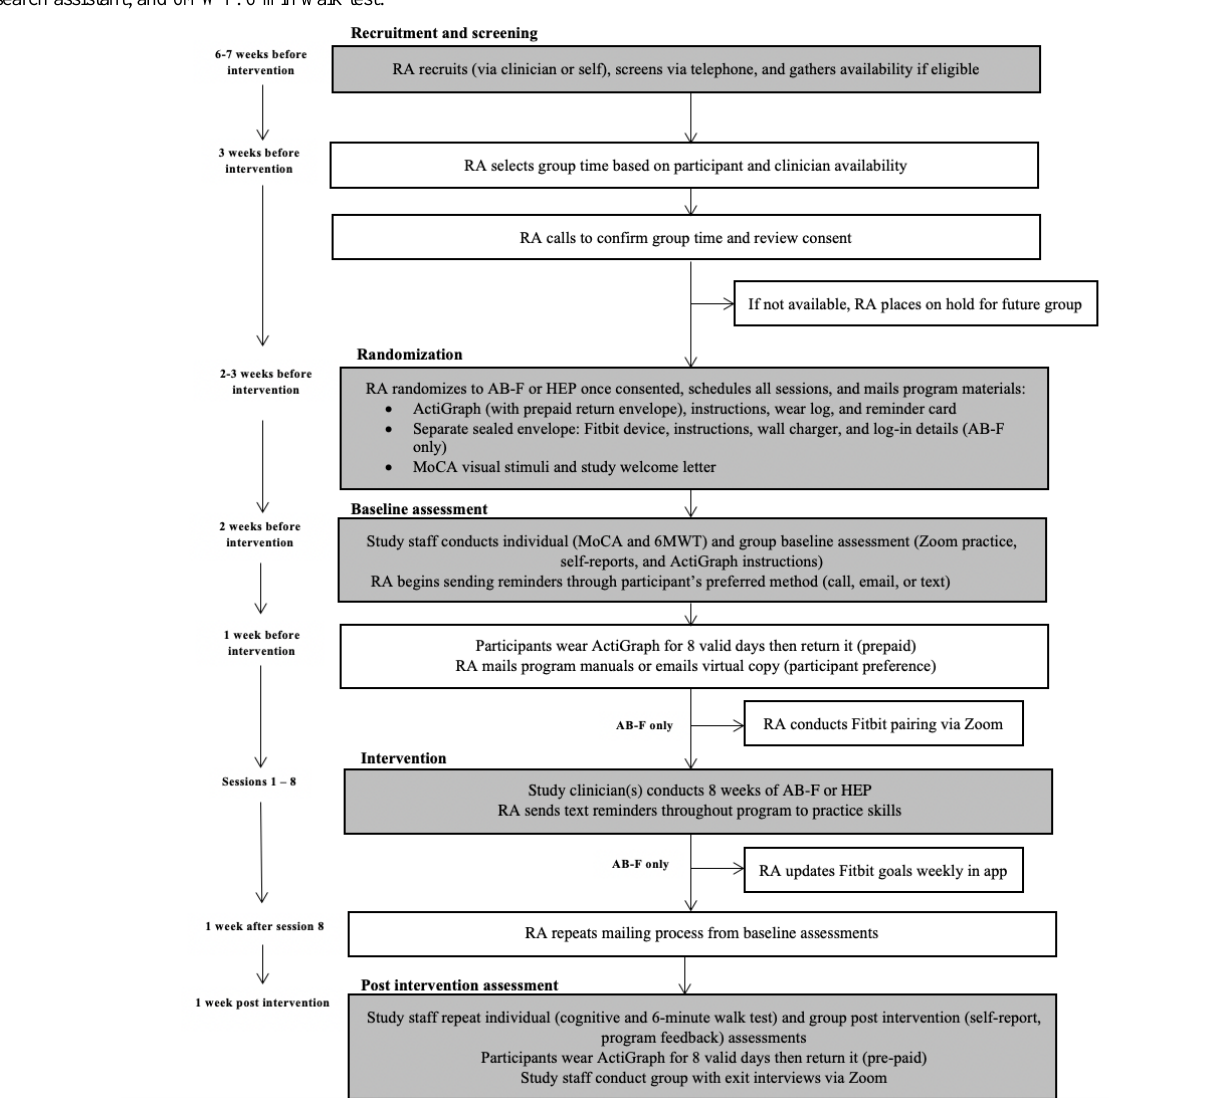
Figure 2. Study design and timeline. AB-F: Active Brains-Fitbit; HEP: health enhancement program; MoCA: Montreal Cognitive Assessment; RA: research assistant; and 6MWT: 6-min walk